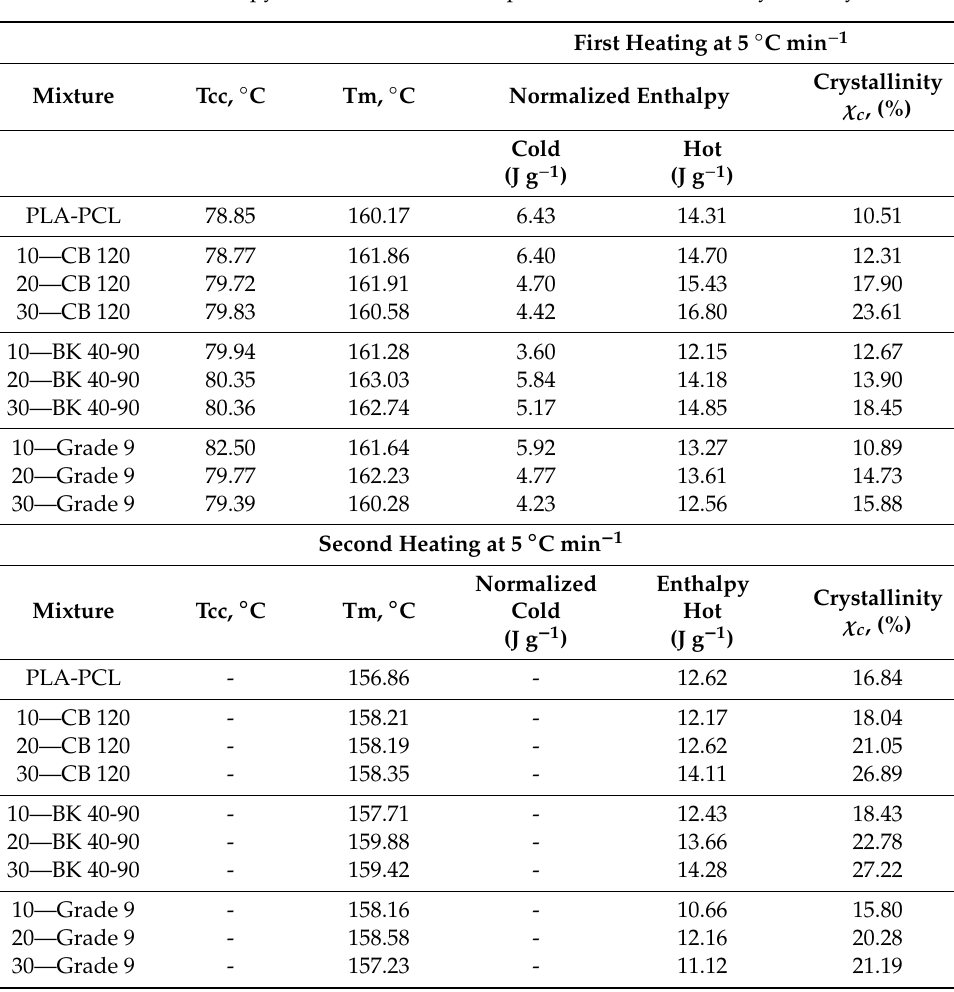
Table 4. Enthalpy values of di ff erent samples and the calculated crystallinity.